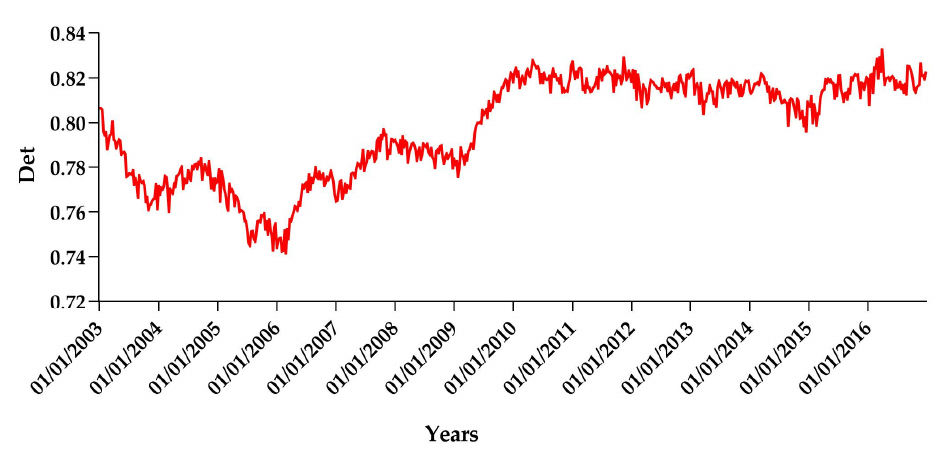
Figure 8. Det profile between farmland and olive grove LSTs from 2003 to 2020 using a time window. Table 4. Statistical analysis on the F-recurrence distribution ex-ante and ex- post 2010. F-Recurrence Mean Std. Dev. F_b-a F tab LST-before